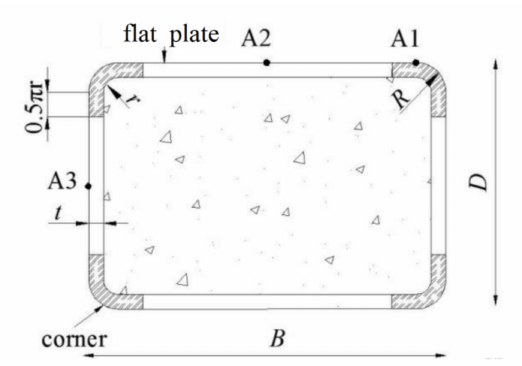
Figure 1. Cross-section configuration.